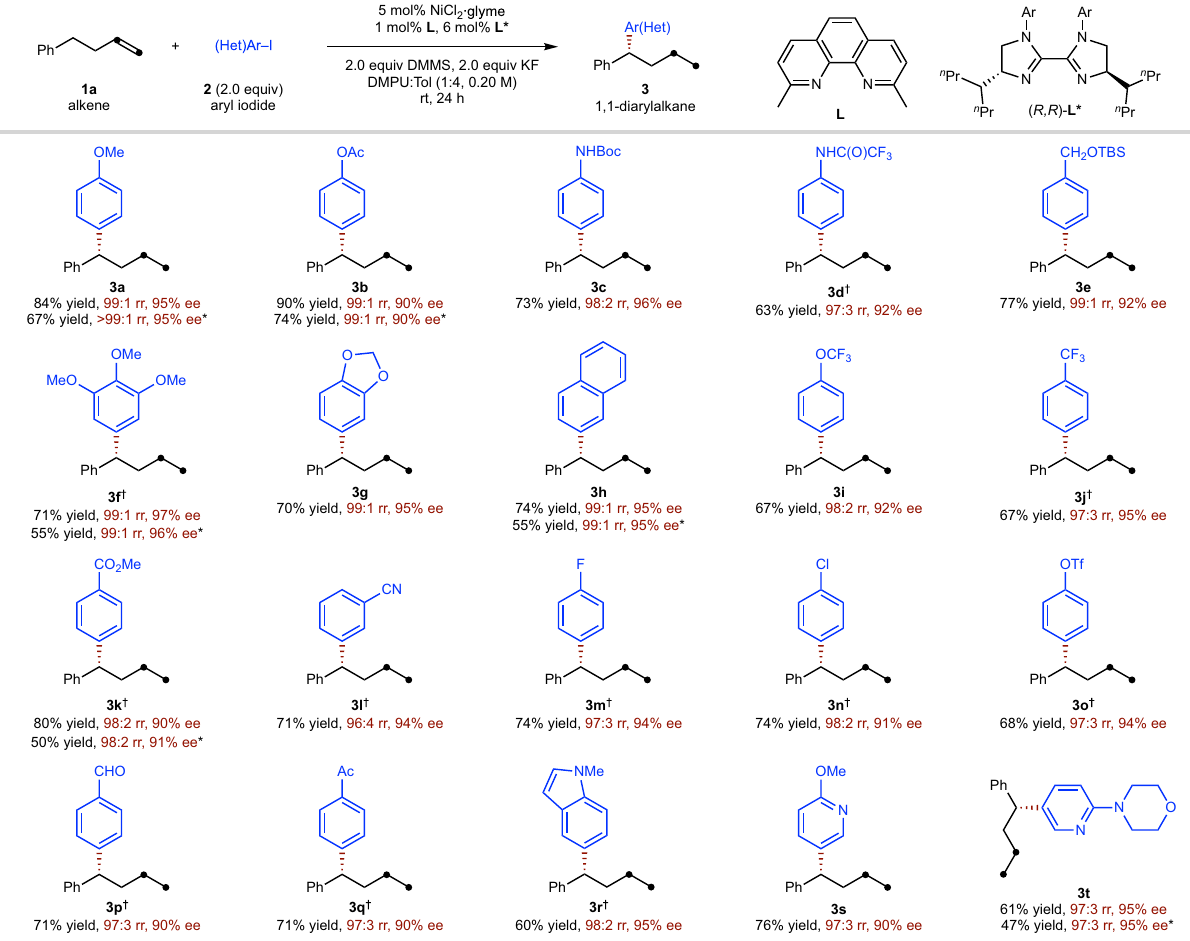
Fig. 3 Substrate scope of aryl halide coupling partner. Yield under each product refers to the isolated yield of puri fi ed product (0.20 mmol scale, average of two runs), regioisomeric ratio (rr) represents the ratio of the major (1,1-diarylalkane) product to the sum of all other isomers as determined by GC and GC-MS analysis, enantioselectivities were determined by chiral HPLC analysis. *Aryl bromide used. † 0.4% L